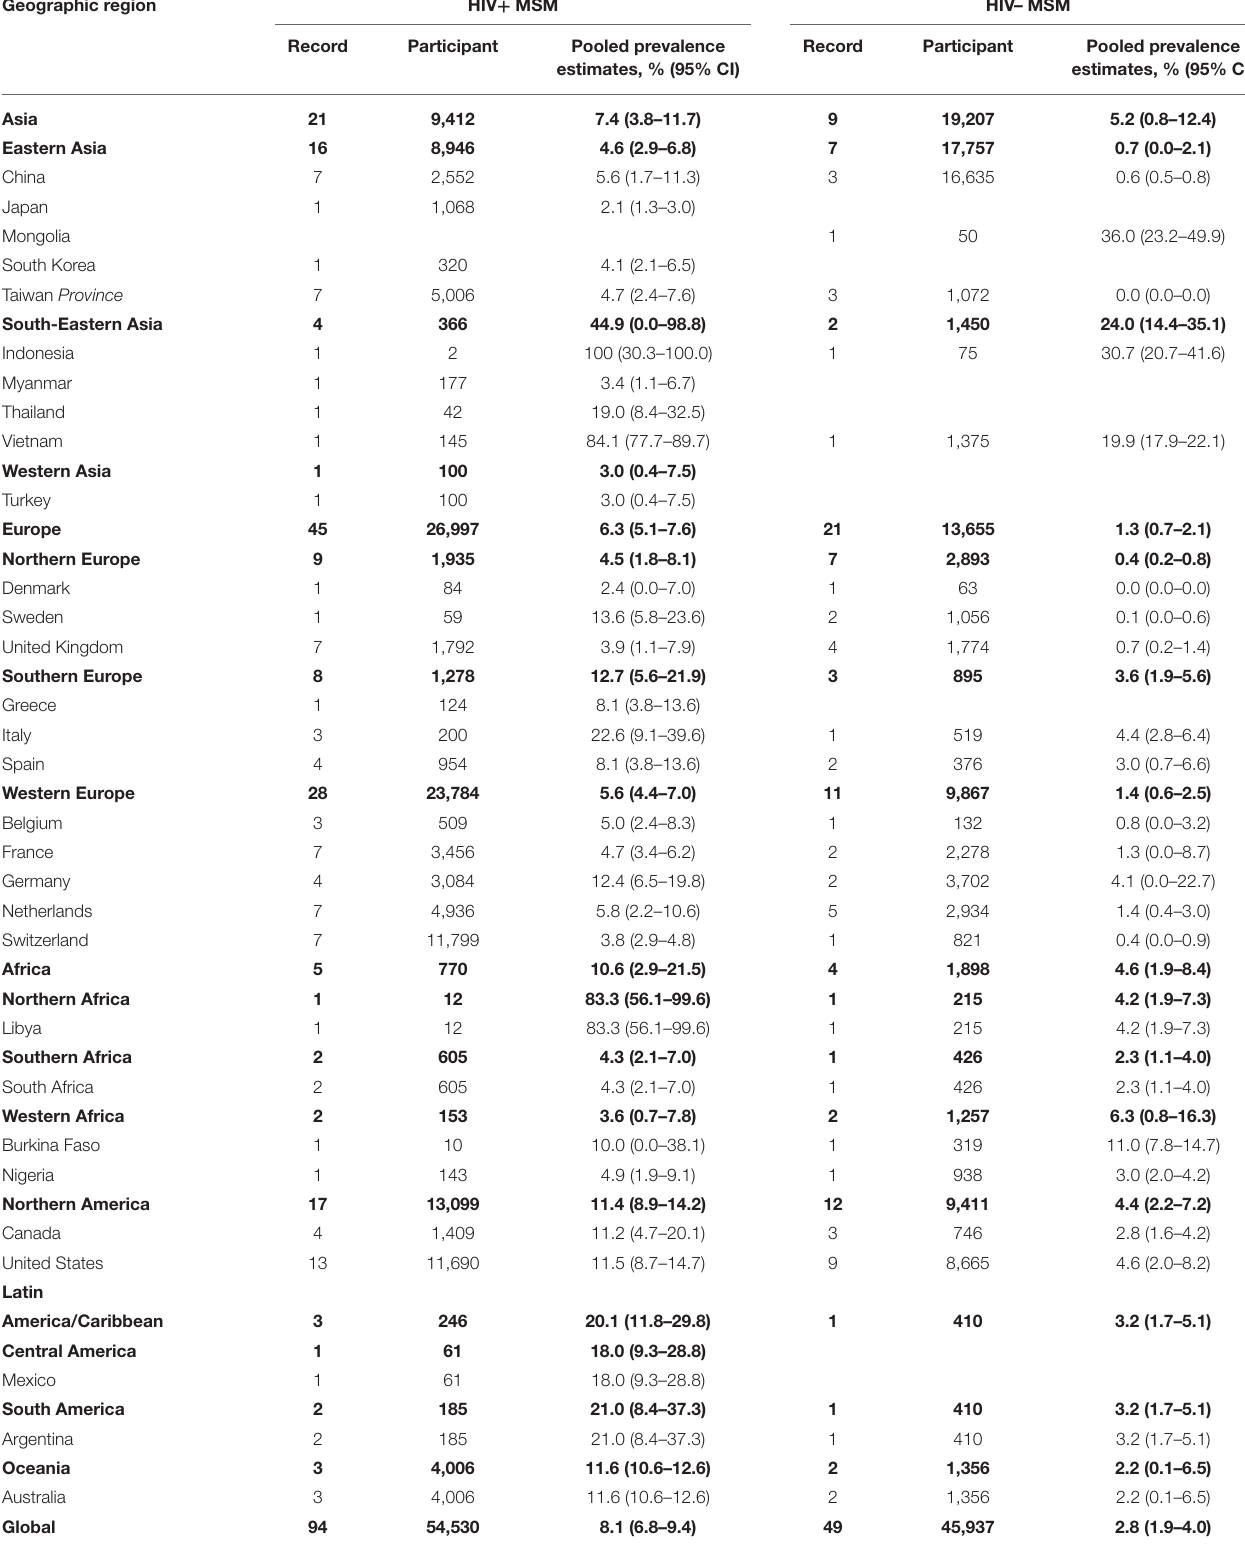
TABLE 3 | Estimates of anti-HCV prevalence by HIV